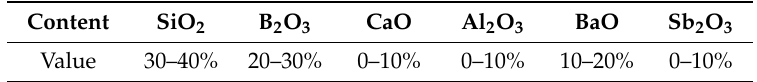
Table 2. The chemical compositions of D-ZK3 glass [42].